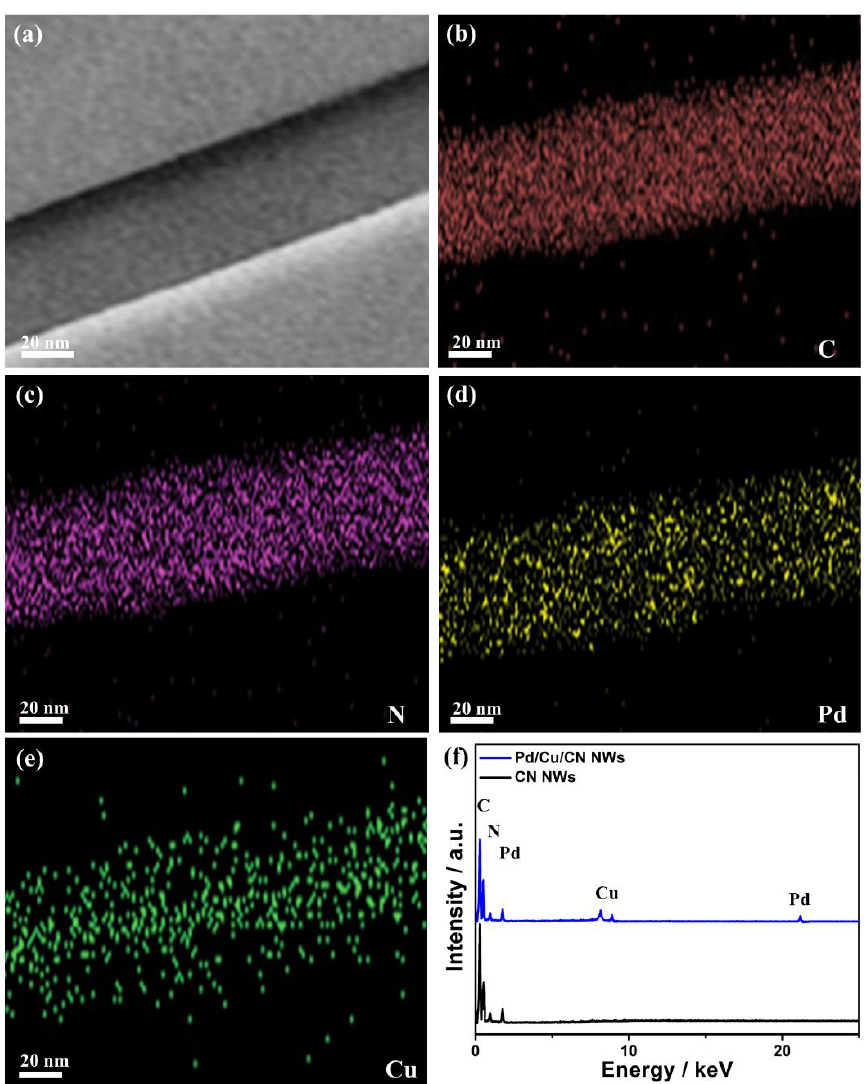
Figure 3. ( a ) HAADF-STEM image of an individual Pd/Cu/CN NWs and its elemental mapping analysis for ( b ) C, ( c ) N, (d) Pd, and ( e ) Cu. ( f ) the EDX analysis of both Pd/Cu/CN NWs and CN